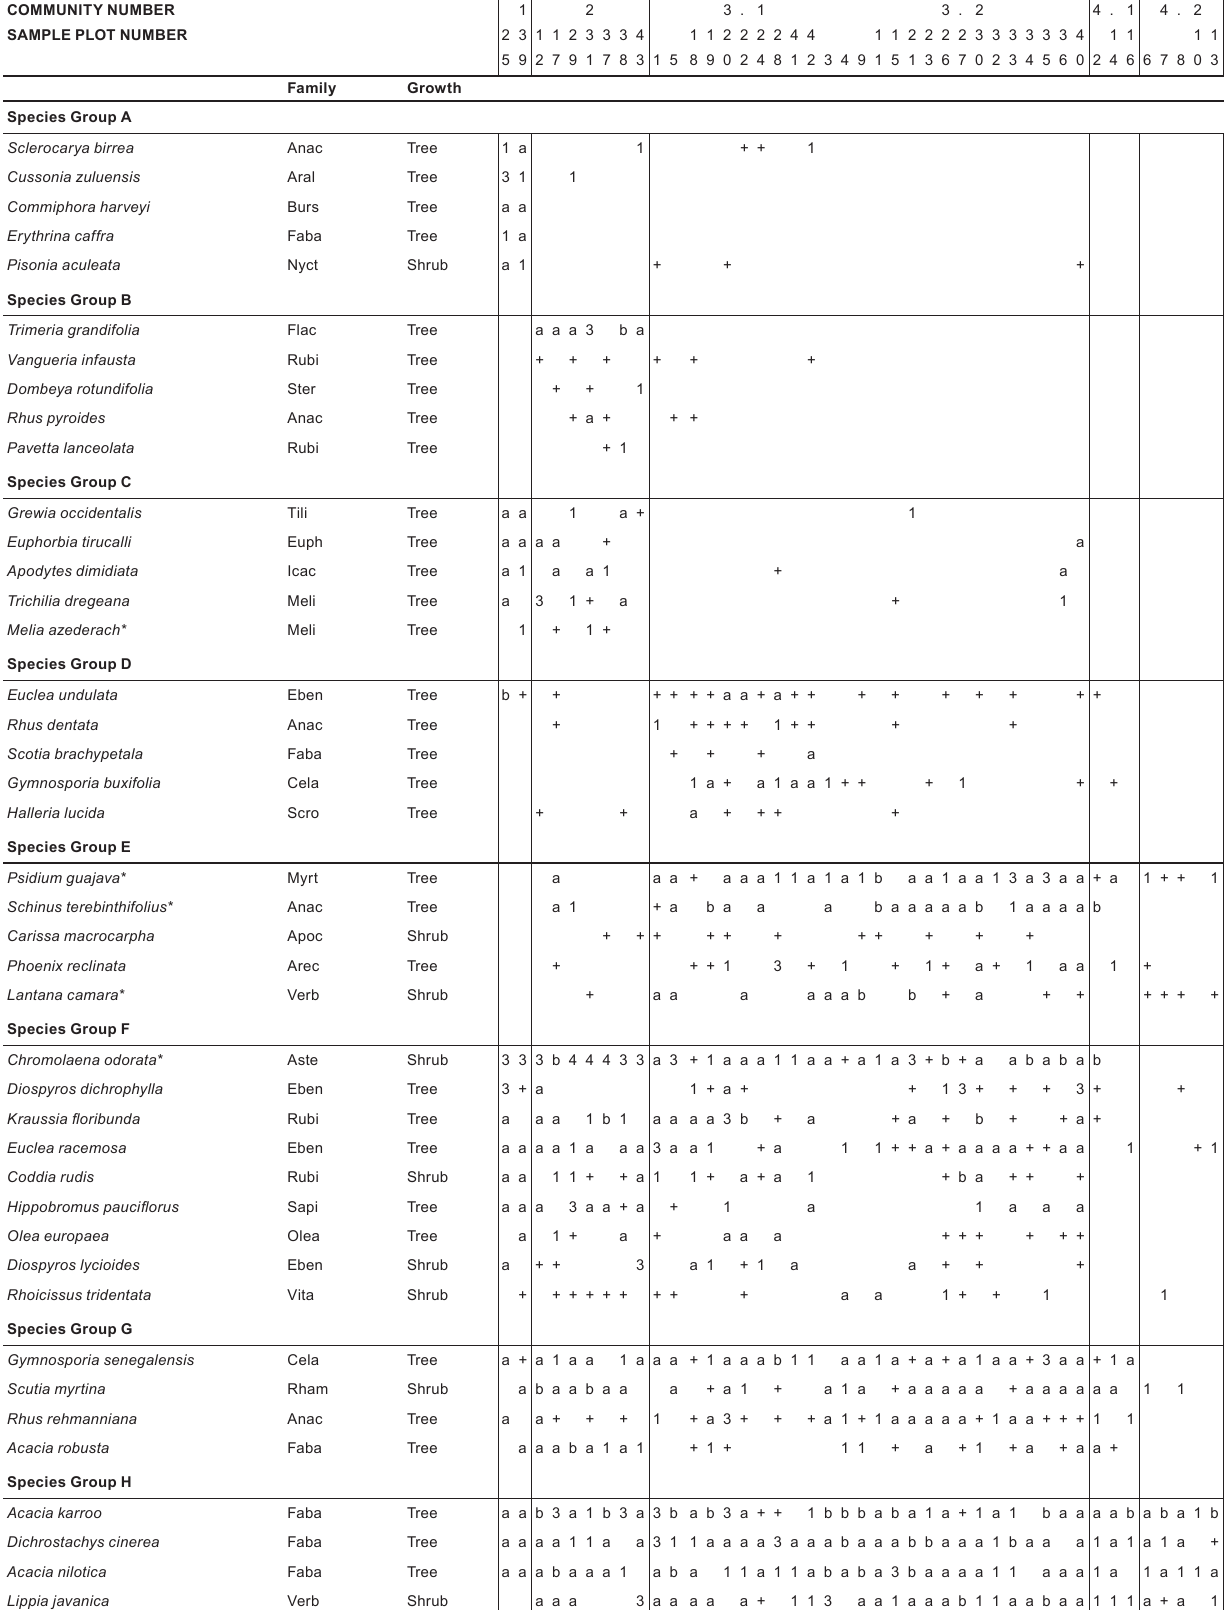
community number sAmPle Plot number